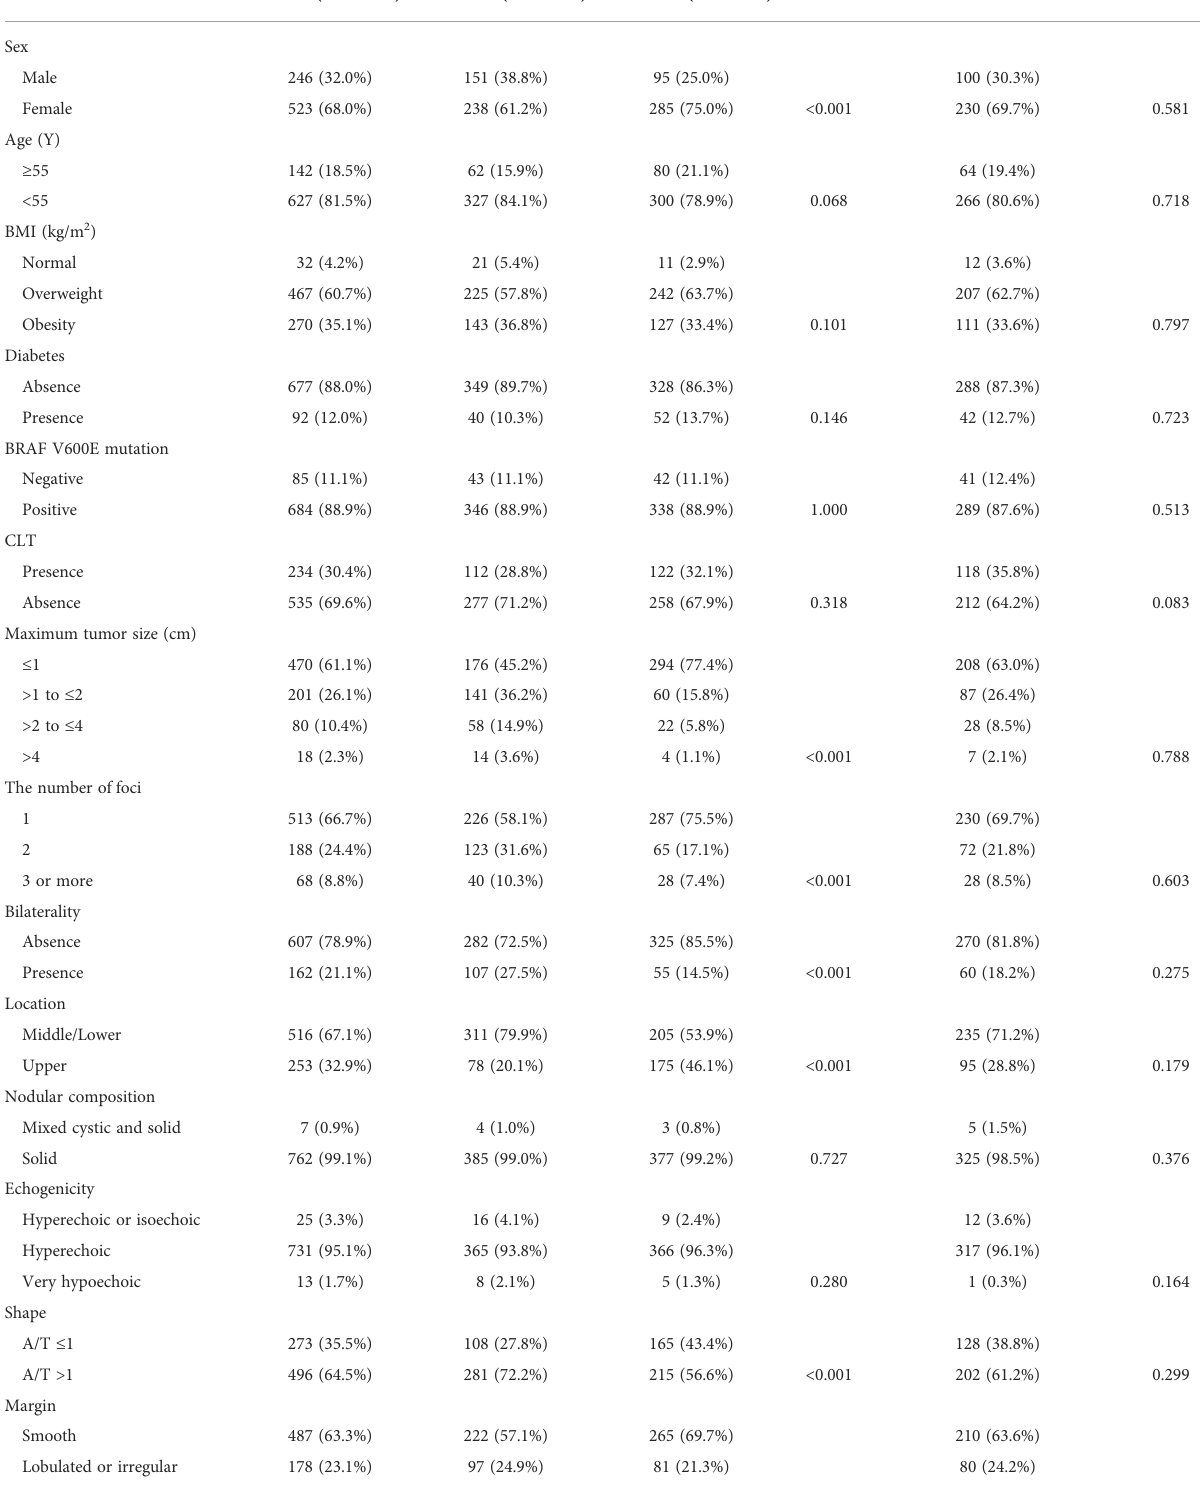
TABLE 1 Clinical and ultrasonic characteristics of the PTC